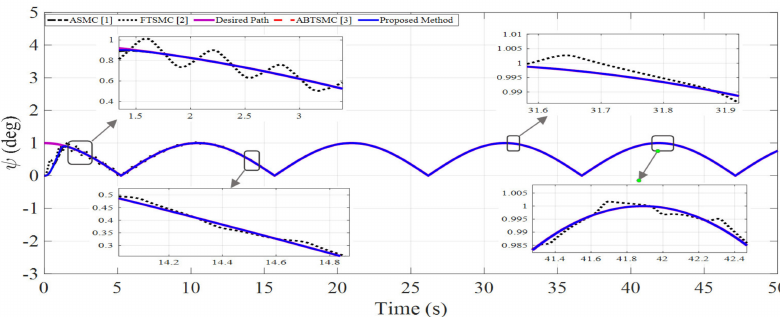
Figure 7. Quadrotor attitude under 50% step fault to actuator 1 and 2.